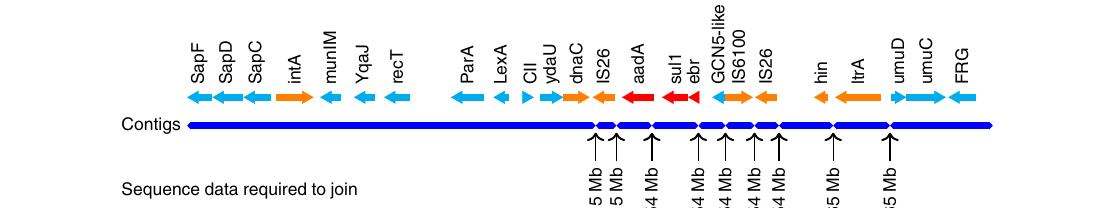
*Circular sequences.